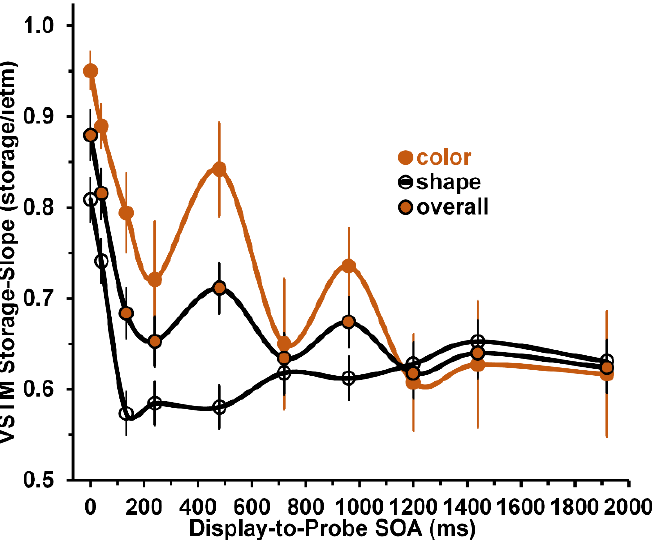
Figure 4. VSTM storage – slopes as a function of SOA. Orange, open, and orange – filled circles depict results obtained for color, shape, and overall results.